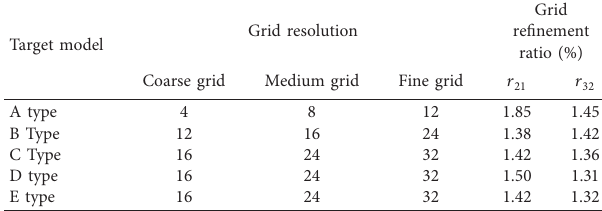
Figure 5: R 2 values for each tested grid condition (E type). (a) Resolution 4. (b) Resolution 8. (c) Resolution 12. (d) Resolution 16. (e) Resolution 20. (f) Resolution 24. (g) Resolution 28. Table 5: Optimal grid resolution derived from the proposed method.